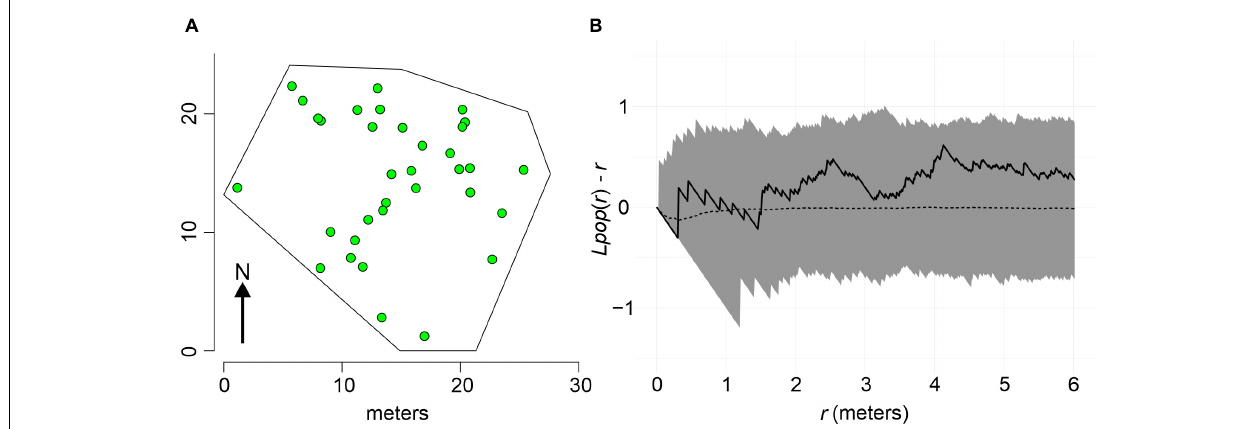
FIGURE 2 | (A) Spatial distribution of P. strigosa colonies at the Bocana site. (B) Random spatial pattern of P. strigosa colonies as indicated by Besag’s transformation plot of Ripleys K of colony pattern distribution. The spatial pattern of the sample (solid line) falls within the 95% confidence envelope (shaded area) of a complete spatial random pattern (dotted line).